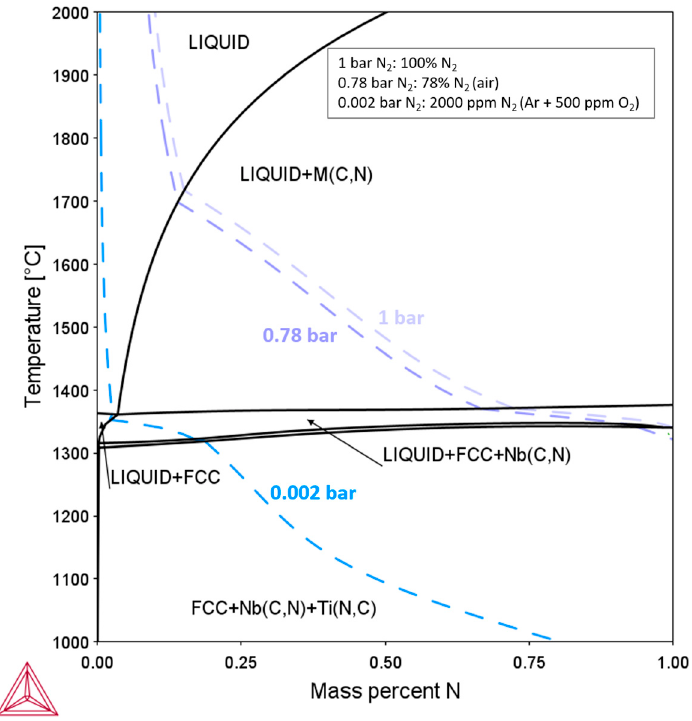
Figure 8. Phase diagram calculated using Thermo-Calc for Alloy 718 and nitrogen along with nitrogen equilibrium isobars.